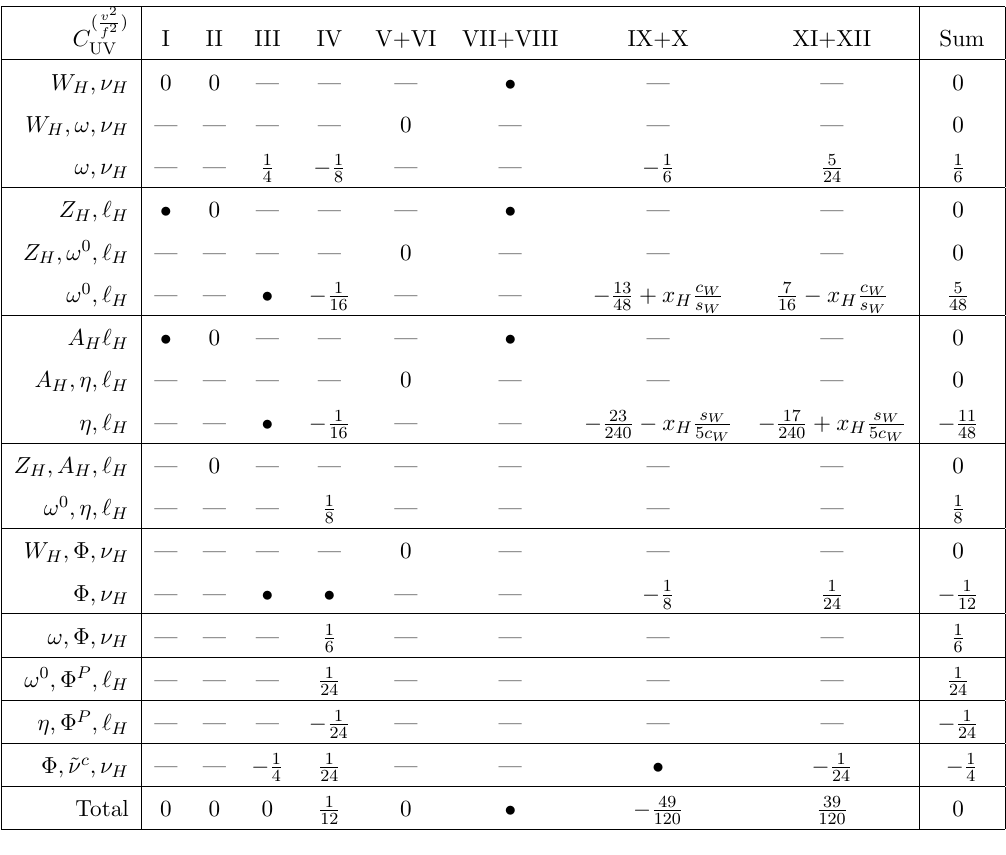
Table 7 . As in table 6 but to O ( v 2 =f 2 ). x H